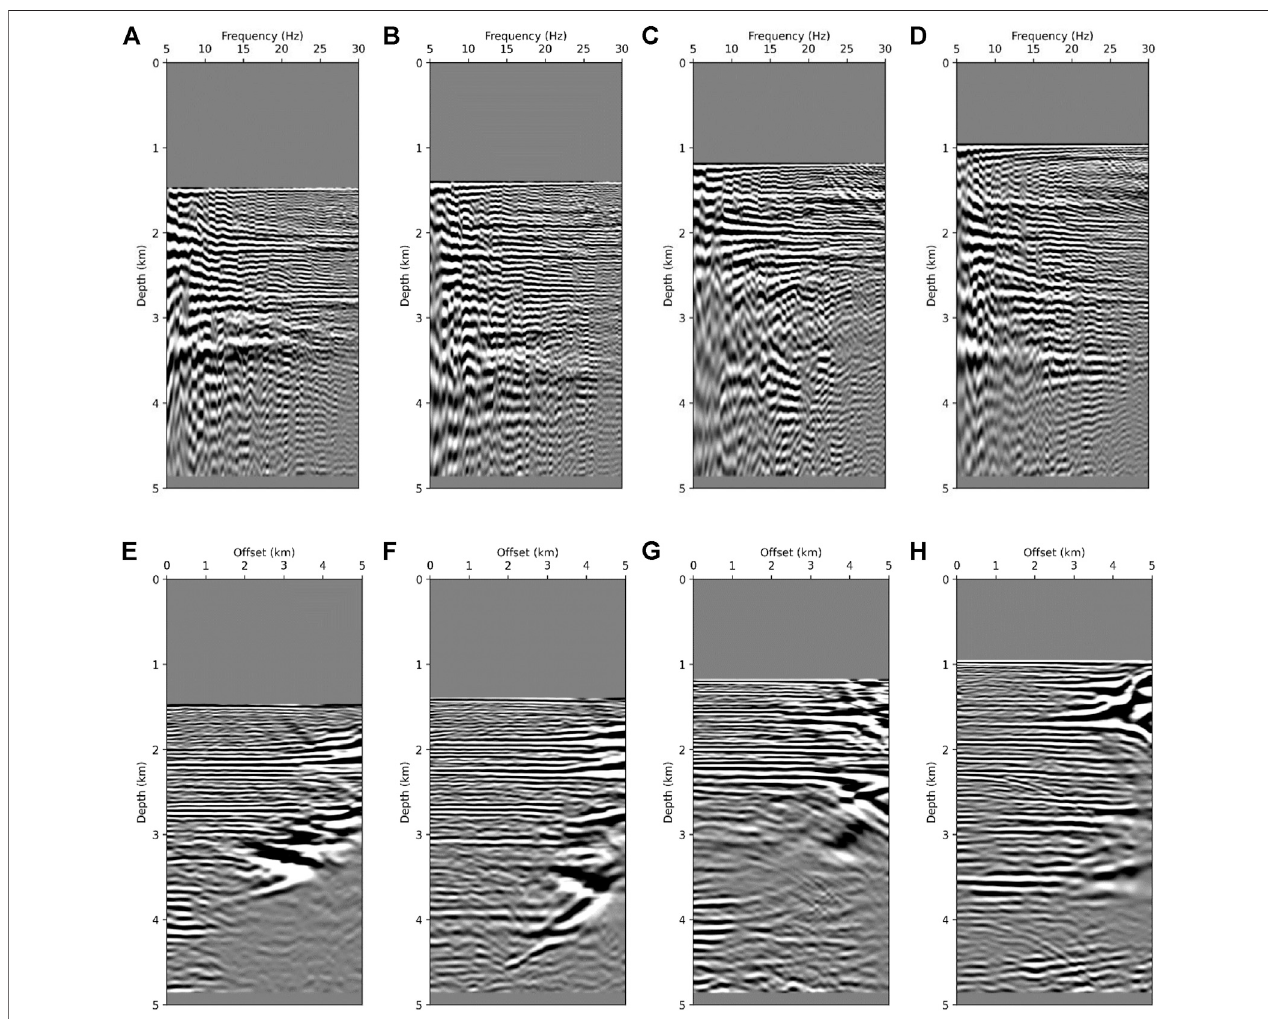
FIGURE 13 | Four FDCIGs of smoothed and inverted velocity model by FWI at (A) 6.25 km, (B) 10 km, (C) 17.5 km, and (D) 23.75 km, and four ODCIGs of same model as that of FDCIGs at (E) 6.25 km, (F) 10 km, (G) 17.5 km, and (H) 23.75 km.